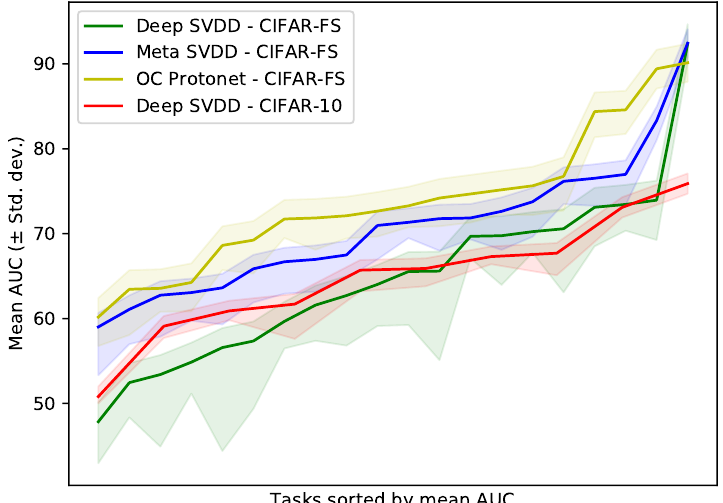
Tasks sorted by mean Figure 2. Mean AUC with shaded standard deviations for tasks in CIFAR datasets sorted by increas- ing mean value. Comparing Deep SVDD across datasets and protocols shows that the modified protocol is reasonable to evaluate few-shot one-class classification because the trend in task difficulty is similar. Within the few-shot protocol in CIFAR-FS, meta one-class classification are numerically superior, show less variance and can be meta-trained once for all tasks, with simple adaptation for unseen tasks, but require related task data.